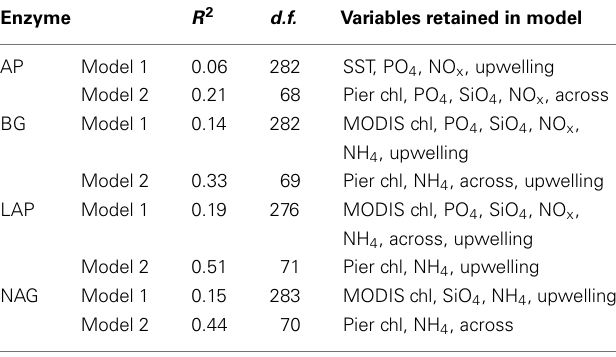
Table 4 |Adjusted multiple coefficients of determination ( R 2 ), degrees of freedom ( d.f. ), and variables retained after stepwise selection in multiple regression analyses (abbreviations as inTable